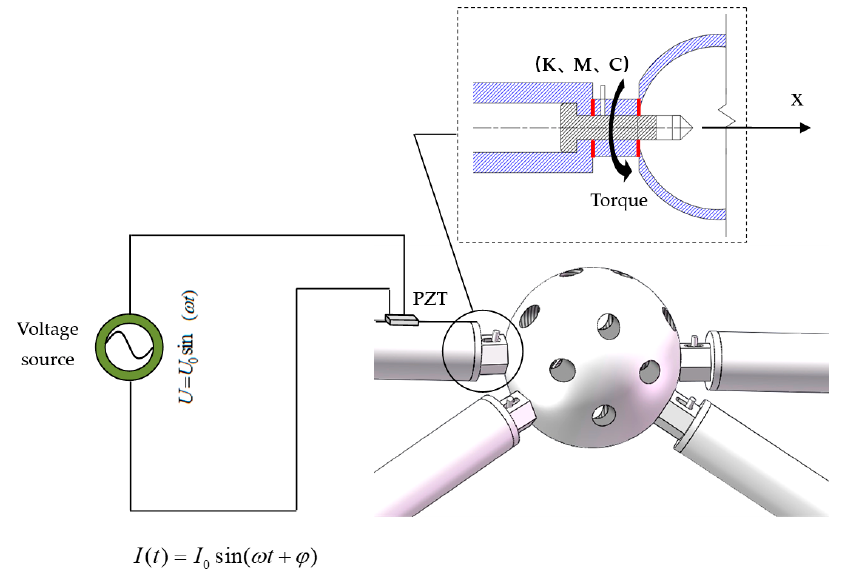
Figure 2. The schematic diagram of electro-mechanical impedance EMI technique by applying the lead zirconate titanate PZT patch.